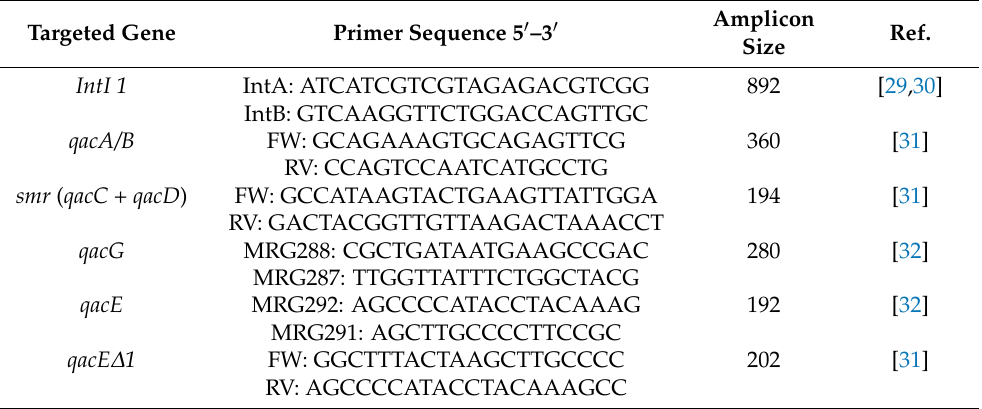
Table 1. Primers used for the detection of integron integrase class 1 gene ( IntI 1 ) and qac resistance